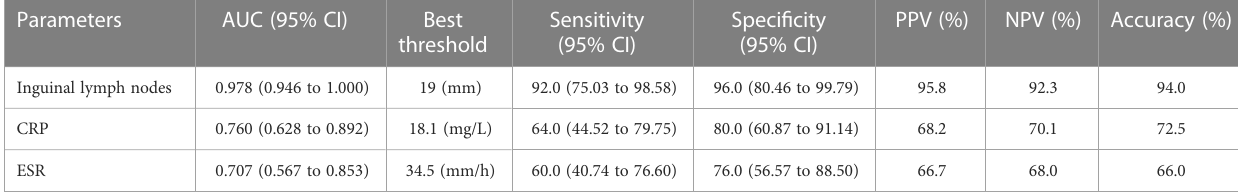
TABLE 3 Performance of these parameters for diagnosing PJI.